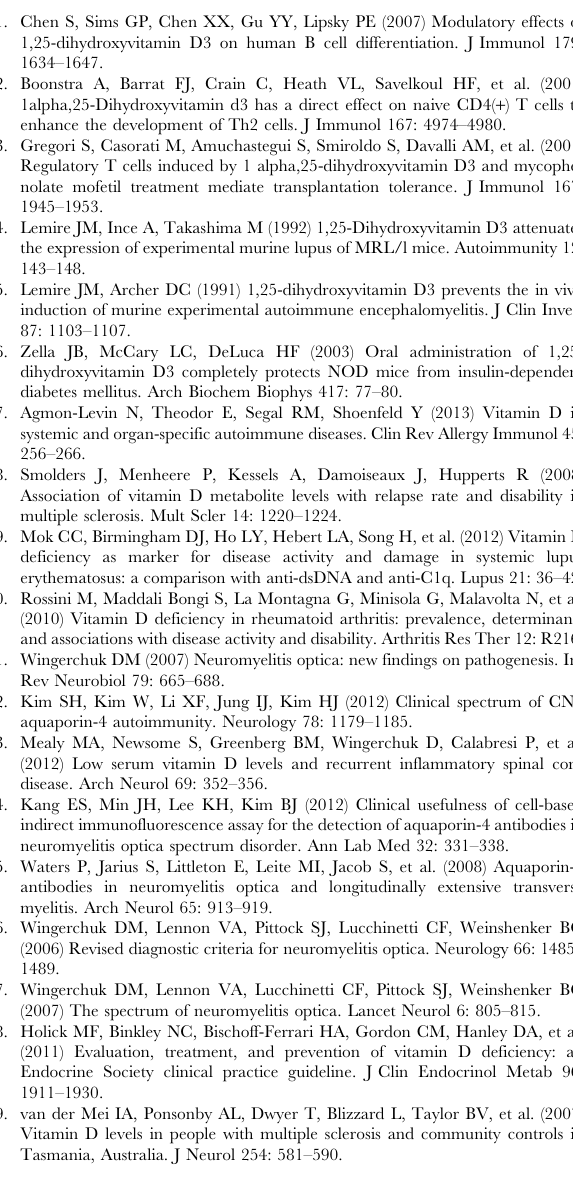
Table S1 The frequency of vitamin D deficiency be- tween patients during an attack (N= 20) and remission (N =31), analyzed by Fisher’s exact test.